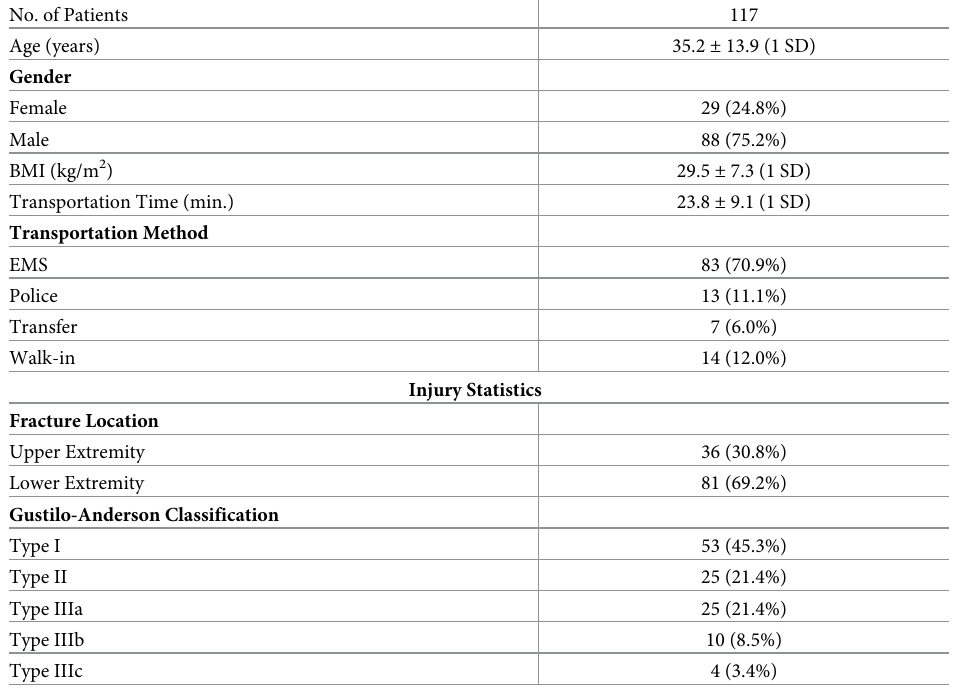
Table 1. Patient demographic data.